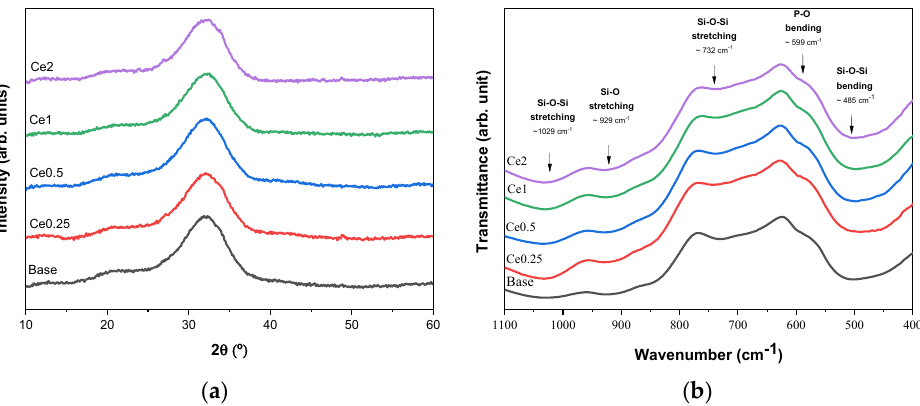
Figure 1. ( a ) XRD diffractogram and ( b ) FTIR spectra of Bioglass 45S5 with several concentrations of cerium (0, 0.25, 0.5, 1, and 2 mol%) .